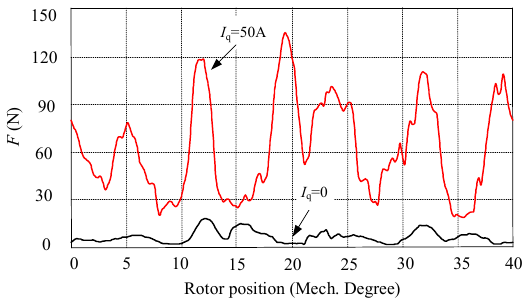
Figure 12. Unbalanced magnetic force ( I q is the quadrature component of the armature current).